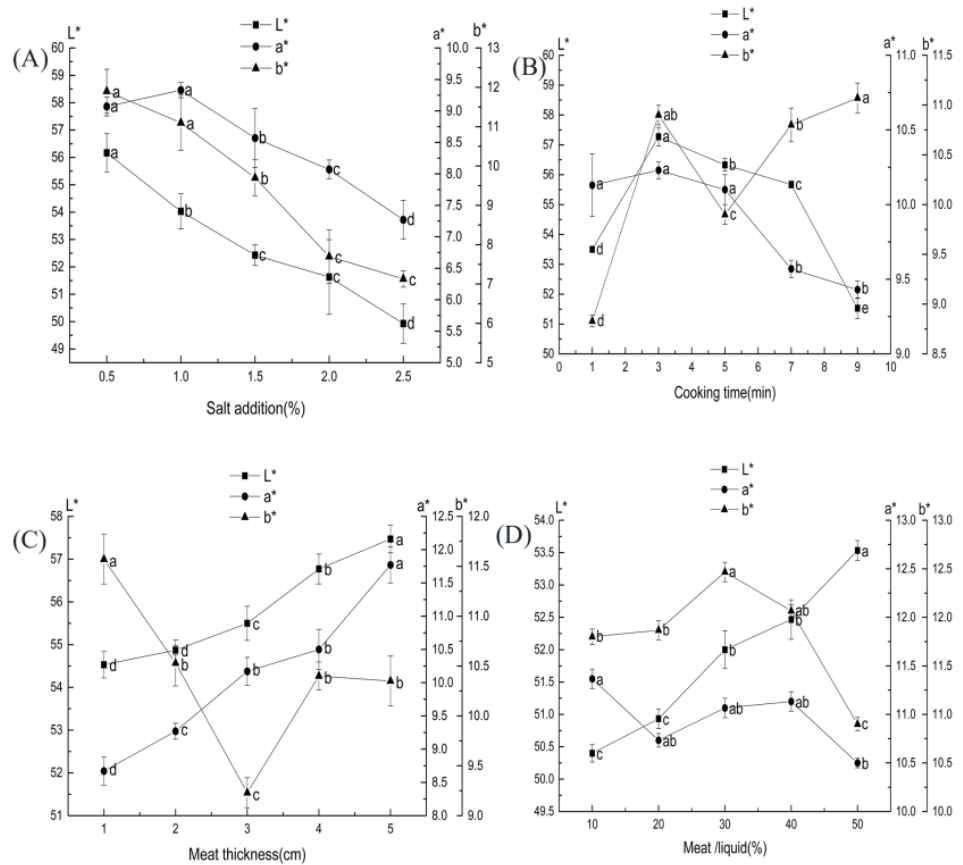
Figure 2. Effect of each factor on the color of ST beef: ( A ) salt addition (based on ST mass); ( B ) cooking time; ( C ) meat thickness; ( D ) beef–ST ratio. Different letters above each bar mean significant differences.